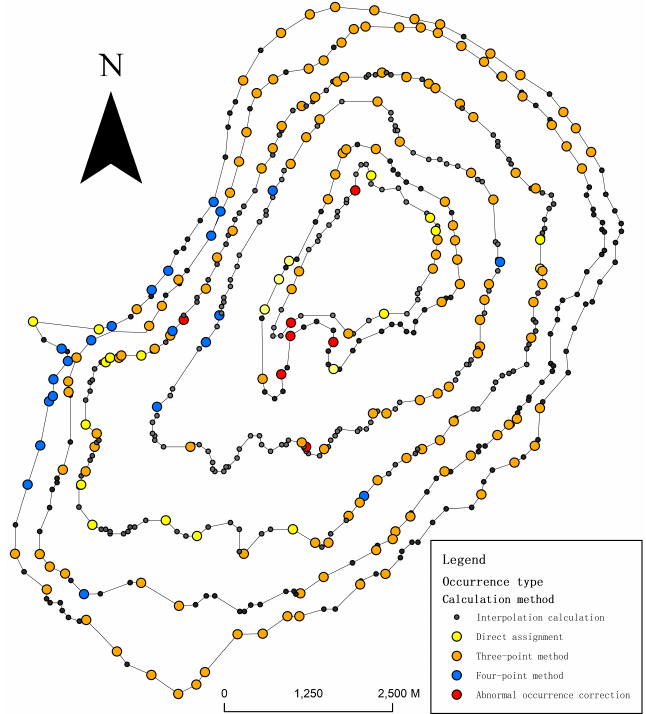
Figure 11. Calculation methods of attitude of boundary points on Wulongshan